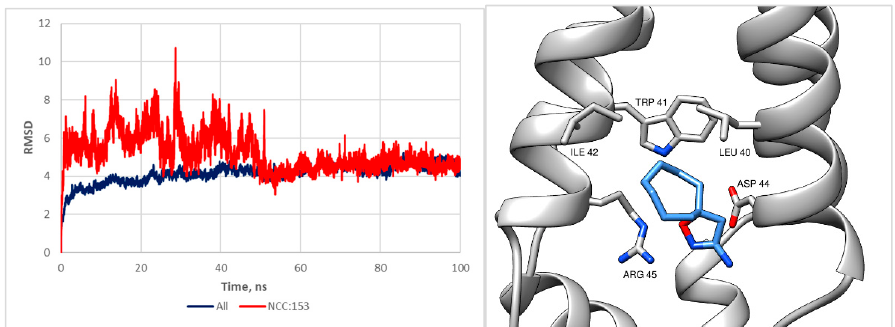
Figure 2. Left: Mass-weighted root mean square deviations of the heavy atoms during the molecular dynamics simulation of the compound 3 /protein/membrane/water/ions system. Right: Structure of the M2 channel (S31N mutant influenza virus, PDB: 2KIH) complex with compound 3 (in blue) obtained after the molecular dynamics simulation (two subunits of the channel, the lipid molecules and hydrogen atoms are omitted for clarity).